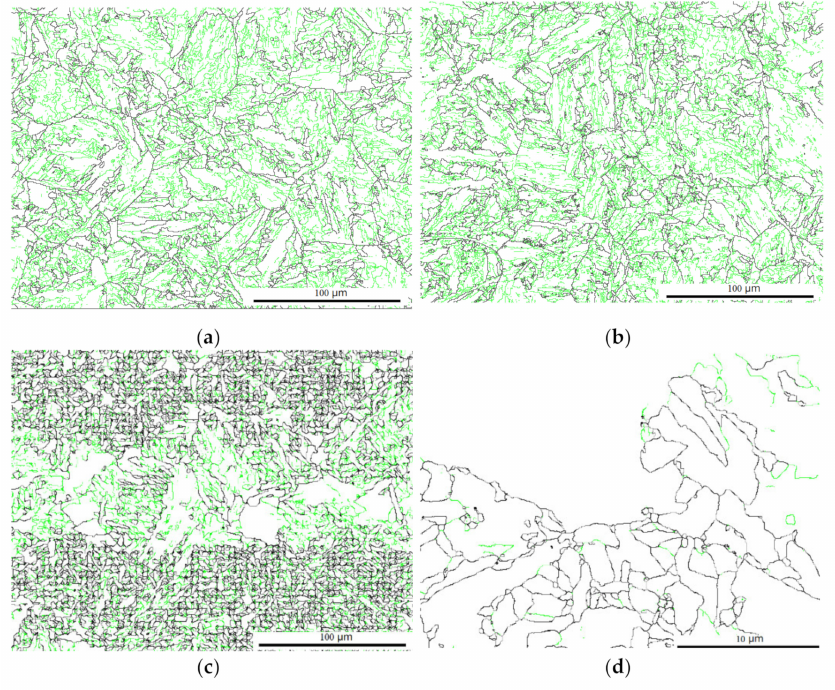
Figure 13. Dislocation density (green line) distribution in the ( a ) as-welded; ( b ) typical; and ( c , d ) spotty cases, and its